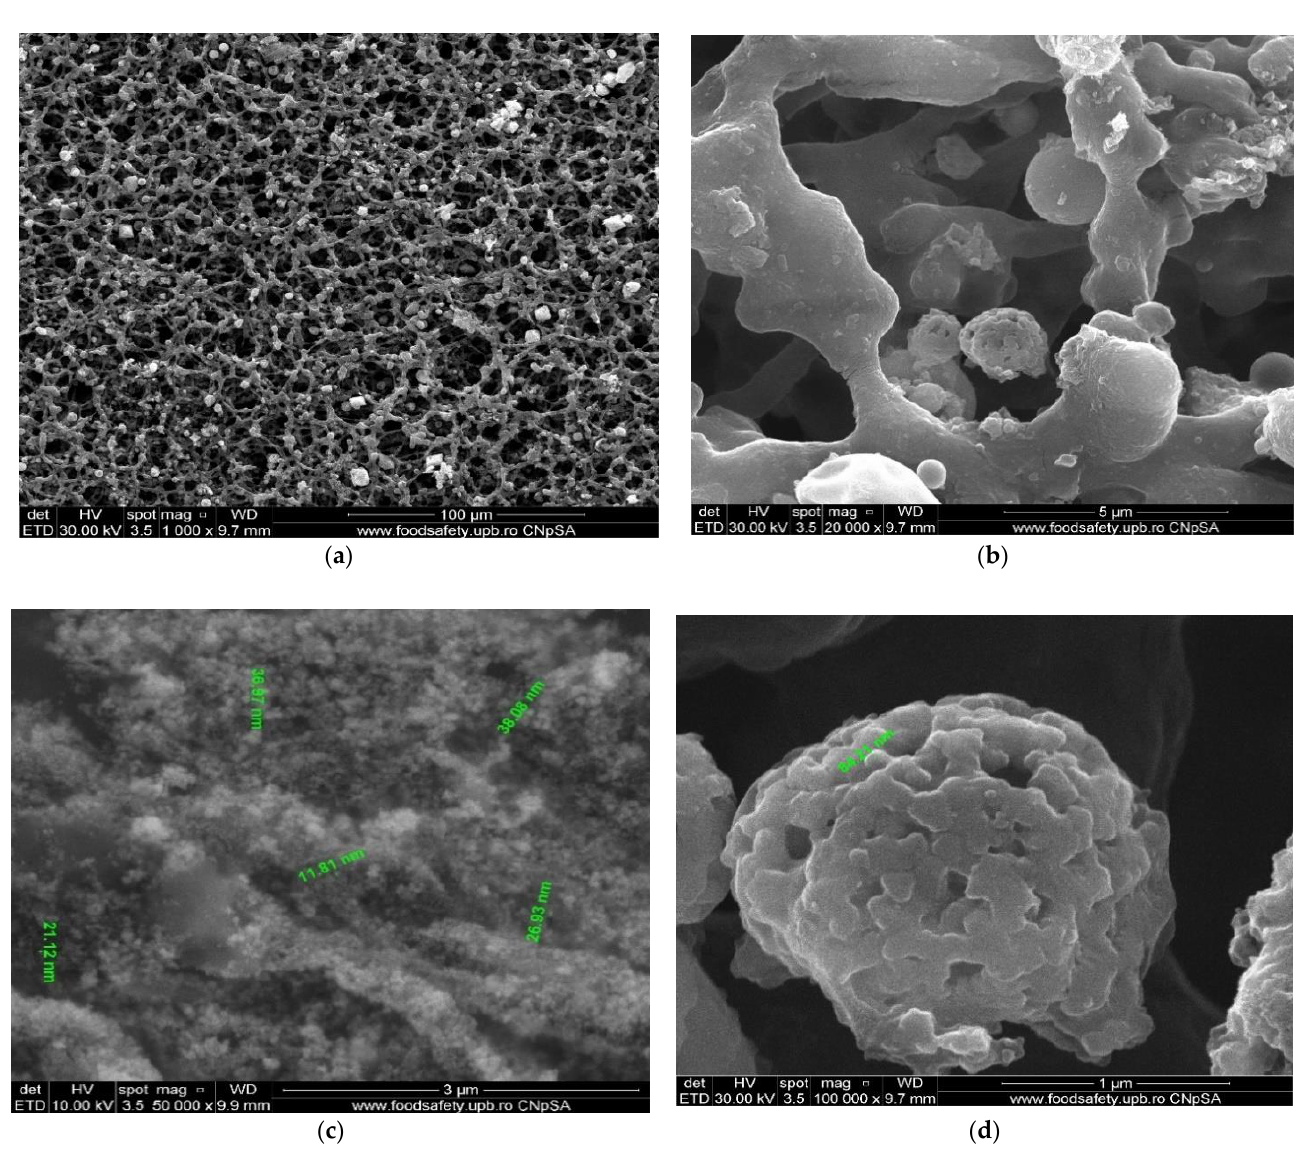
Figure 7. The bottom surface of the cellulose acetate ( a ) and the polysulfone ( b ) membranes, and cross section ( c ) of the polypropylene membranes .